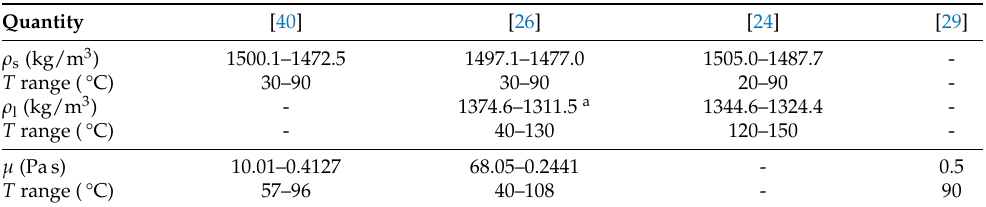
Table 3. Measurements of density in the liquid ( ρ l ) and solid ( ρ s ) phases and viscosity ( µ ) of xylitol as a function of temperature collected from the literature.